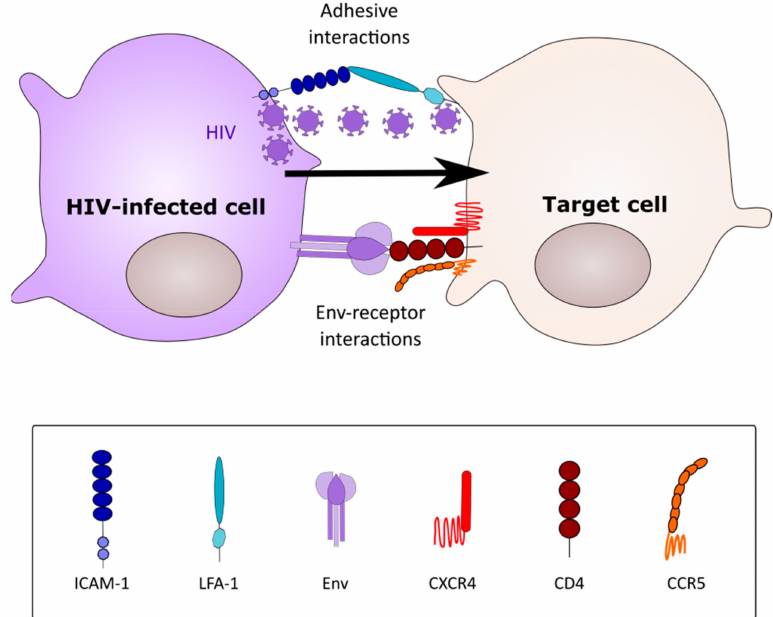
Figure 1. A prototypical virological synapse. The infected cell (CD4 + T cell or macrophage) forms a transient adhesive contact with a receptor-expressing target cell via Env-CD4 interactions (CD4 + T cell-T cell synapses) or via adhesion molecule interactions (macrophage-CD4 + T cell synapse). Virus buds from the infected cell and migrates towards receptors clustered on the target cells (arrow). Infection follows via conventional receptor-mediated